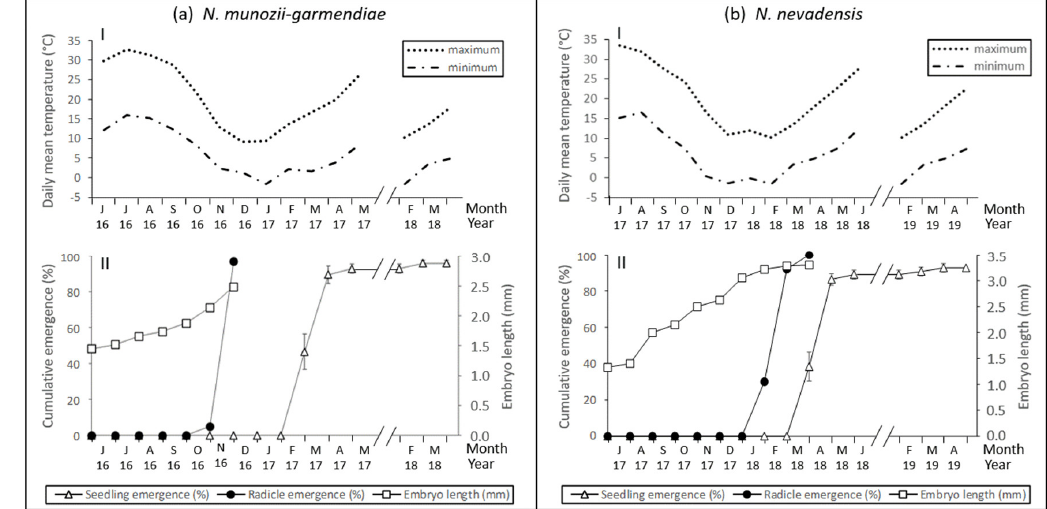
Figure 2. Phenology curves for: ( a ) N. munozii-garmendiae seeds sown in soil in an unheated shade house during June 2016; and ( b ) N. nevadensis seeds sown during July 2017. The daily mean minimum and maximum air temperatures (I) and phenology of the embryo length, root emergence, and seedling shoot emergence (II) are shown in ( a , b ).